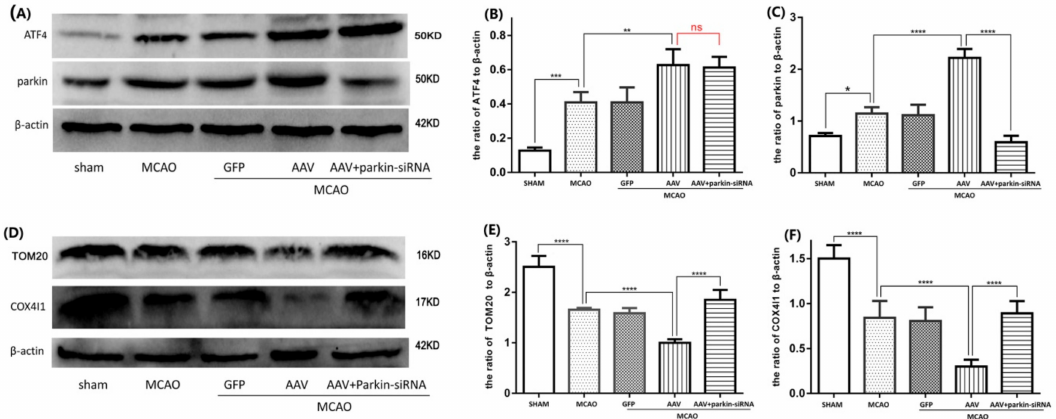
Figure 5. Parkin siRNA significantly impaired the e ff ects of ATF4 on parkin expression and mitophagy activity. Compared with the AAV + MCAO group, parkin siRNA remarkably decreased parkin expression ( A , C ), however, it has no obvious influence on ATF4 expression ( A , B ). Parkin siRNA apparently increased the levels of TOM20 and COX4I1 compared to the AAV + MCAO group ( D – F ). Error bars represent mean ± SD. (* p < 0.05, ** p < 0.01, *** p < 0.001 and **** p < 0.0001 vs. indicated group). n = 5 in each group. MCAO, middle cerebral artery occlusion-reperfusion; GFP, green fluorescent protein; AAV, ATF4 overexpression adeno-associated virus; siRNA, small interfering